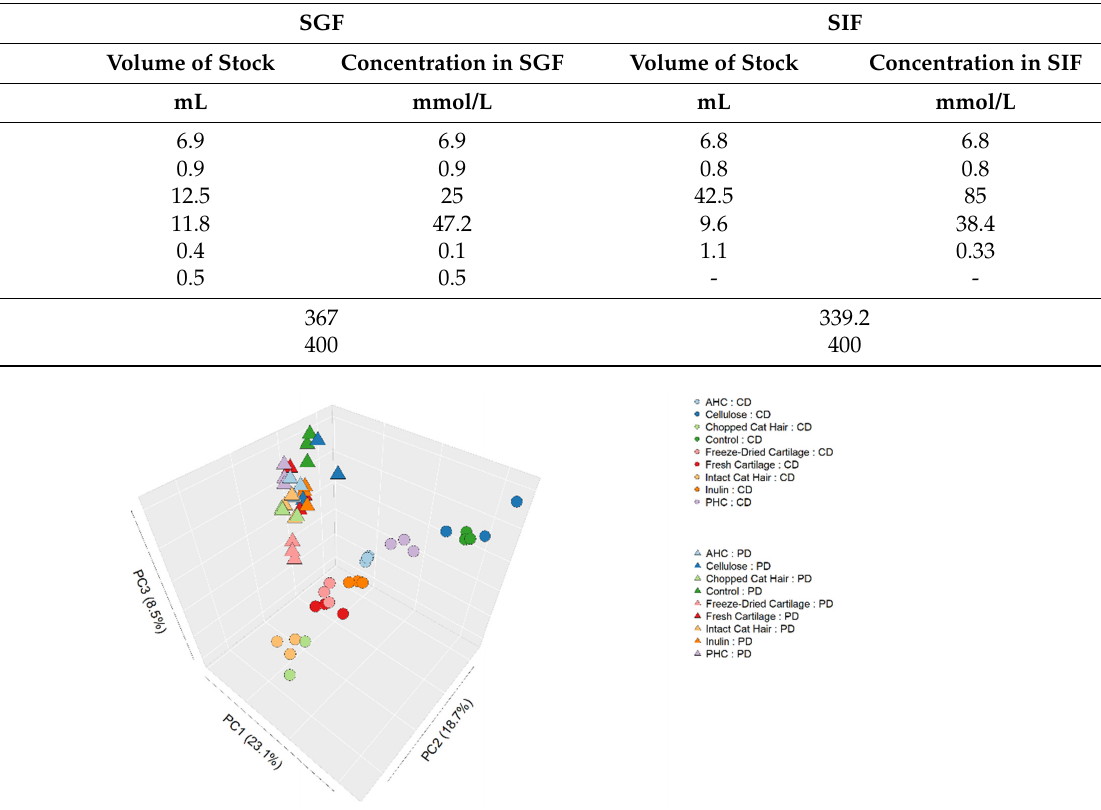
Figure A3. Assessment of alpha diversity using the Chao1 diversity index from samples following in vitro fermentation of substrates at the 24-h time point using high carbohydrate faecal inoculum (CD). Small circles denote outliers.